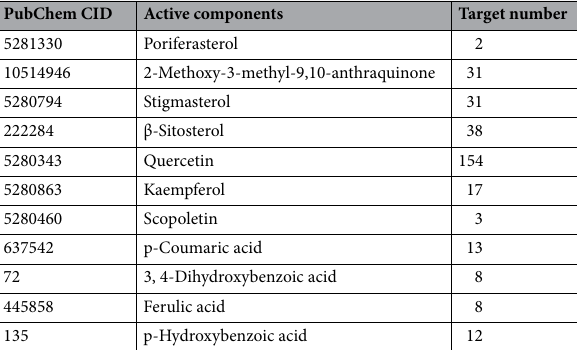
Table 1. Active components and numbers of corresponding potential HDW targets.